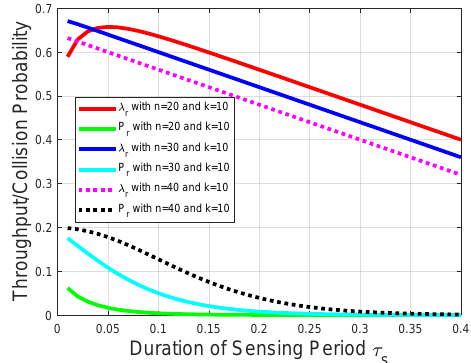
Figure 4. Throughput and collision performances of the CRN with a given reporting period and k in the “ k -out-of- n ” fusion rule.